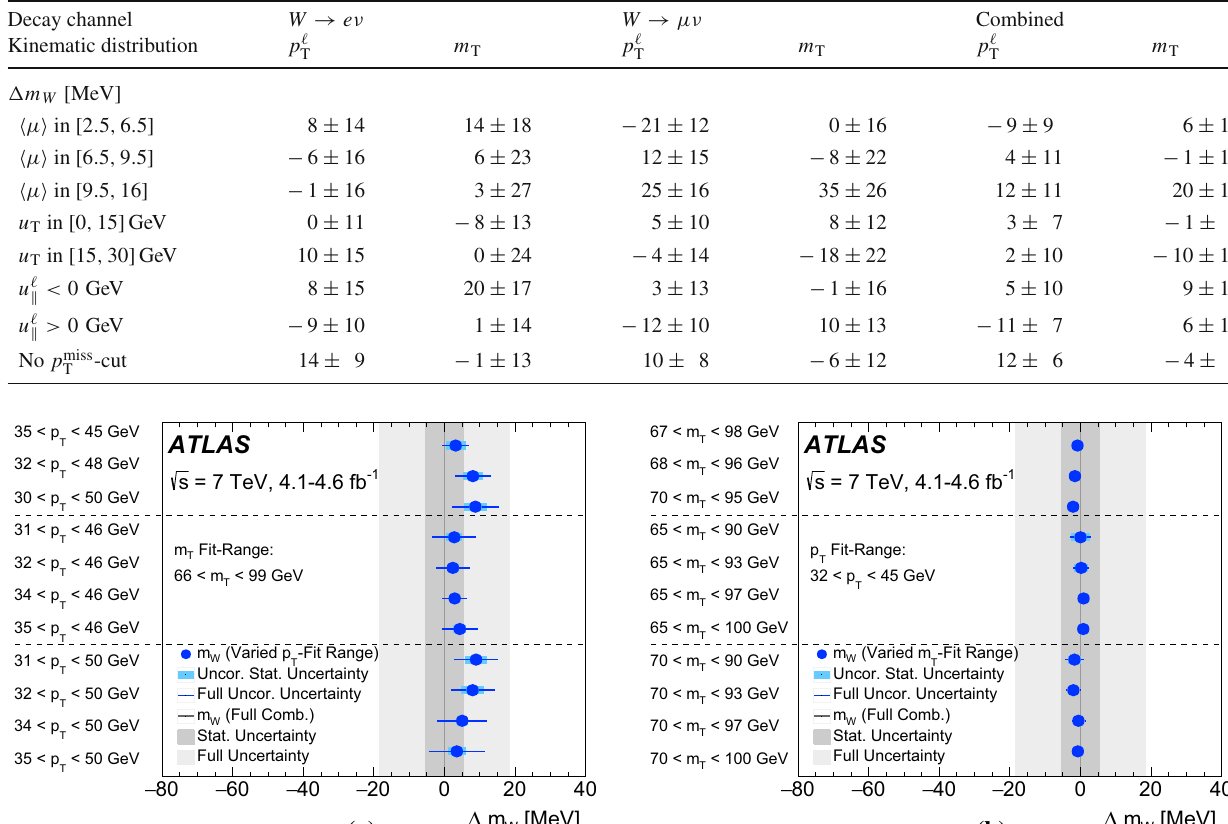
tainties correspond to the statistical uncertainty of the fit to the data of each category alone. Fitting ranges of 30 < p (cid:7) 65 < m T < 100GeV are used or m T ).Theuncer- T